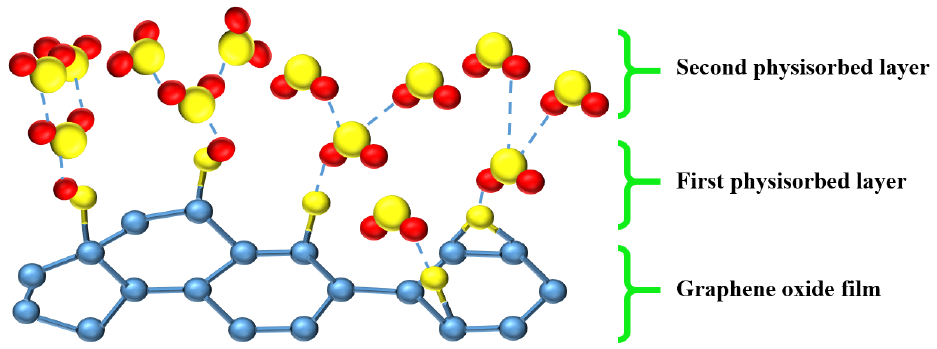
Figure 18. The schematic sensing mechanism of GO.